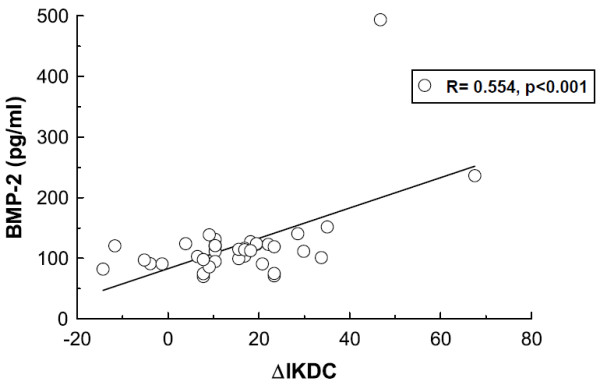
Association BMP-2 and IKDC Score. Significant positive correlation between differences of the IKDC Score evaluated initially and after 1 year and initial intraarticular BMP-2 concentrations in all patients undergoing ACI or microfracturing (R = 0.554, p < 0.001)